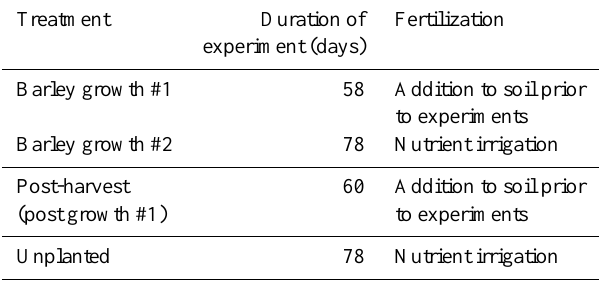
Table 1. Overview over mesocosm experiments. The post-harvest experiment was the successive of the barley growth experiment #1.